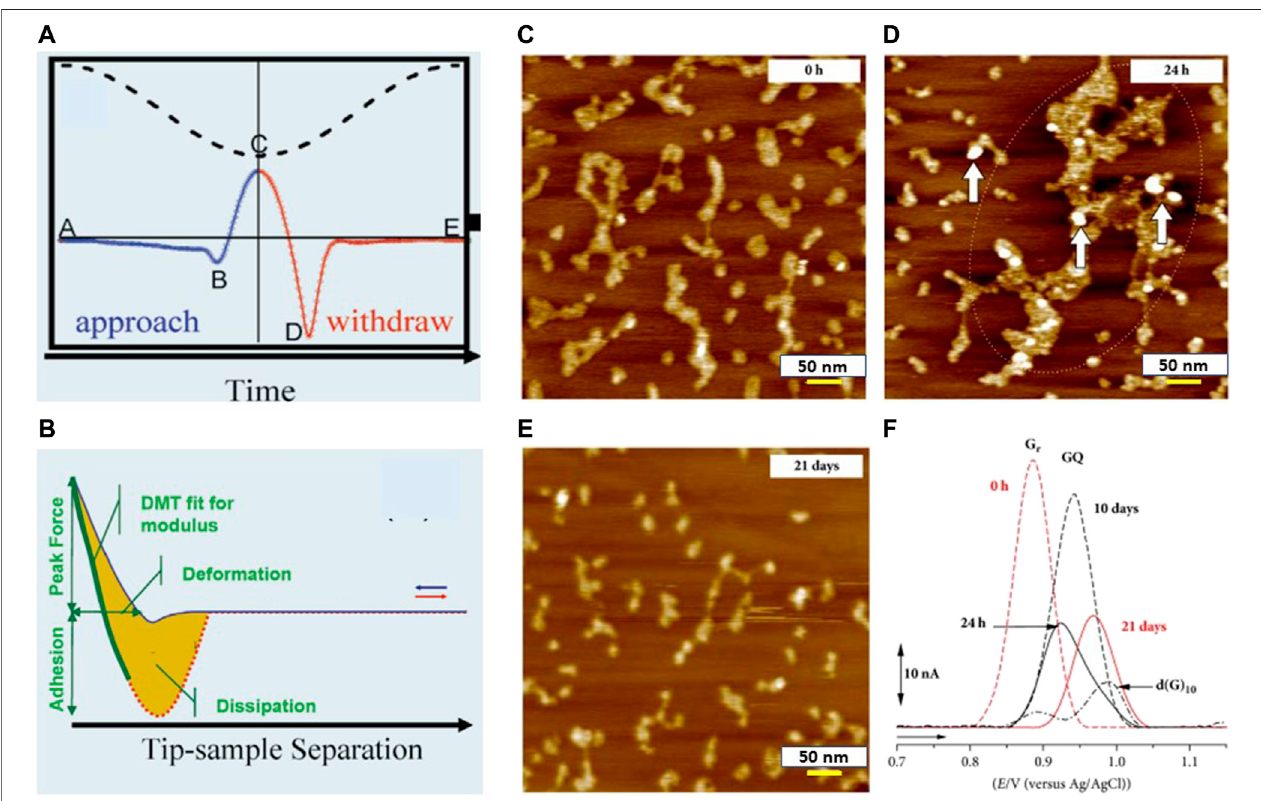
FIGURE7|(A) Plotofappliedforce ontheAFM probeandZpositionofthepiezoelectricscannervs.time:pointBrepresents thebeginningoftip – samplecontact, pointCrepresentsthepeakforce,andpointDrepresentsadhesion(courtesy:Applicationnote#128,Bruker). (B) Appliedforcevs.tip – sampleseparationplotwherethe sum ofcantilever de fl ectionandzpiezo positionrepresents thetip – sampleseparation(courtesy:Application note#128,Bruker). (C – E) AFM imagesofpoly(G)inpH7.0 (5 µg/ml)when K+ ions werepresentin thesolutionwith incubation time of (C) 0 h, (D) 24 h, and (E) 21 days. (F) DP voltammograms baseline of100 µg ml − 1 poly (G) with different durations of incubation (Chiorcea-Paquim et al.,